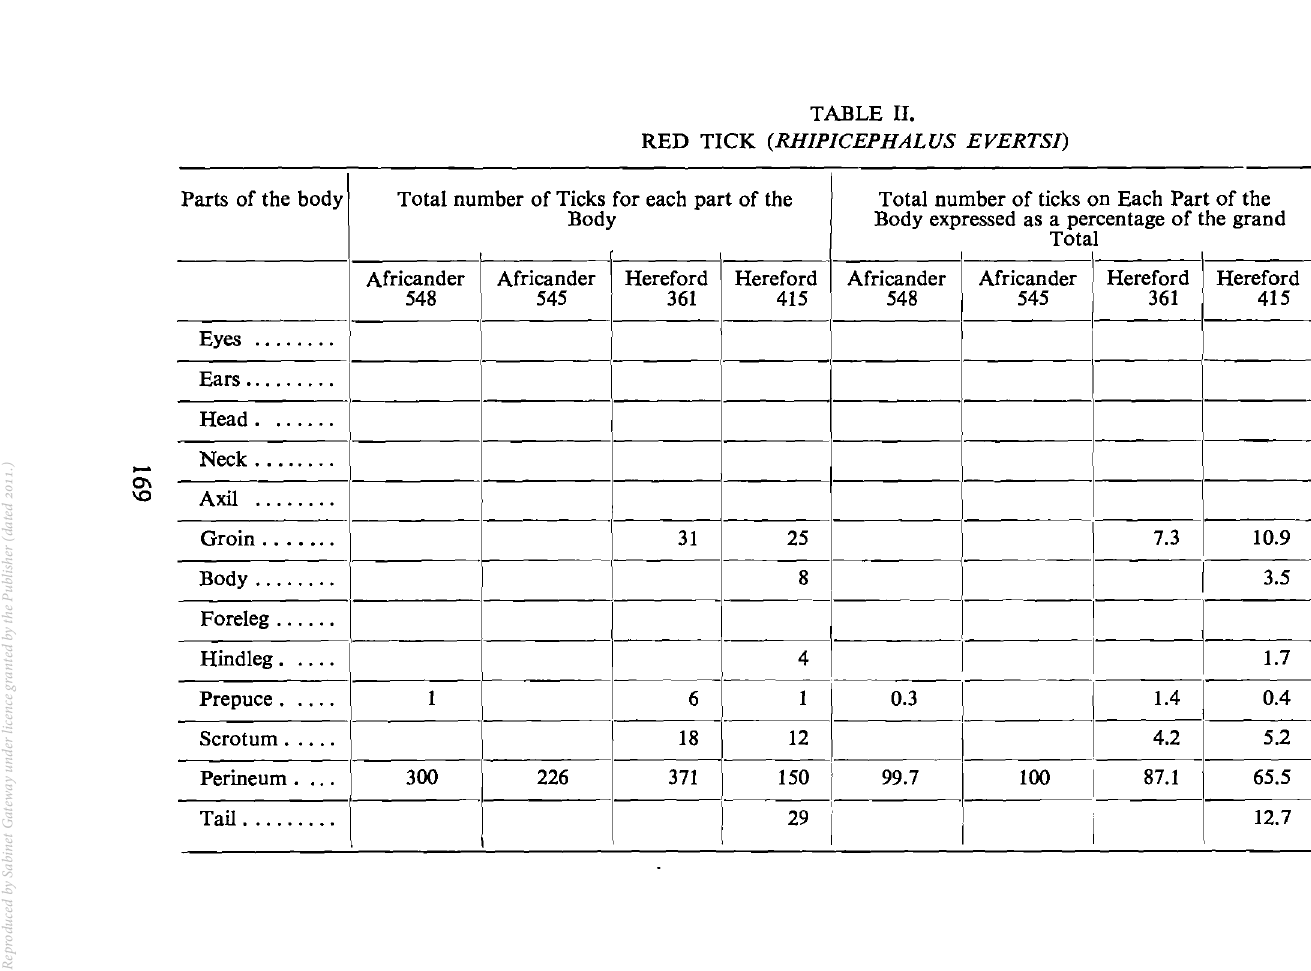
RED TICK (RHIPICEPHALUS EVERTSI) Total number of Ticks for each part of the Total number of ticks on Each Part of the Body Body expressed as a percentage of the grand